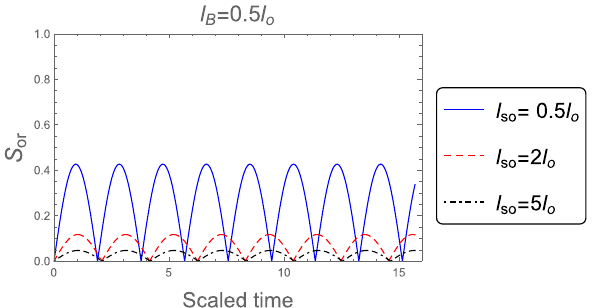
�( 0 ) e, 0 , for distinct | � = | �